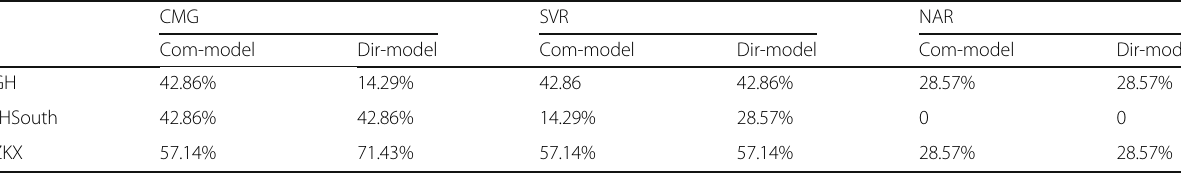
Table 4 Prediction accuracy of AQI